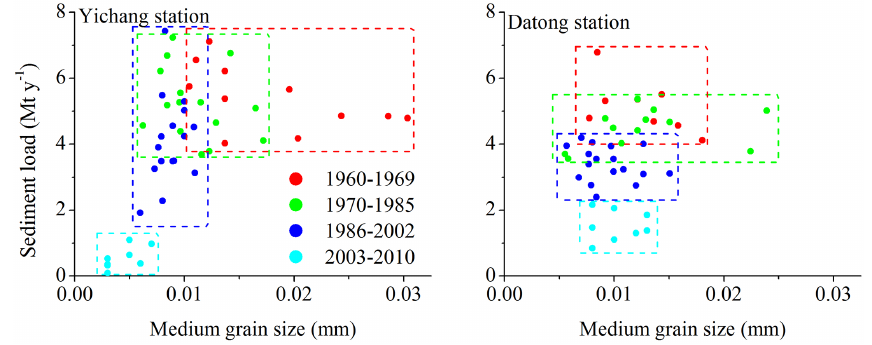
Figure 6. Relationship between the medium grain size of suspended sediments and the sediment load during different periods at the Yichang and Datong stations. Data are not available for the Datong station in 1968–1970, 1972–1973, and 1975.